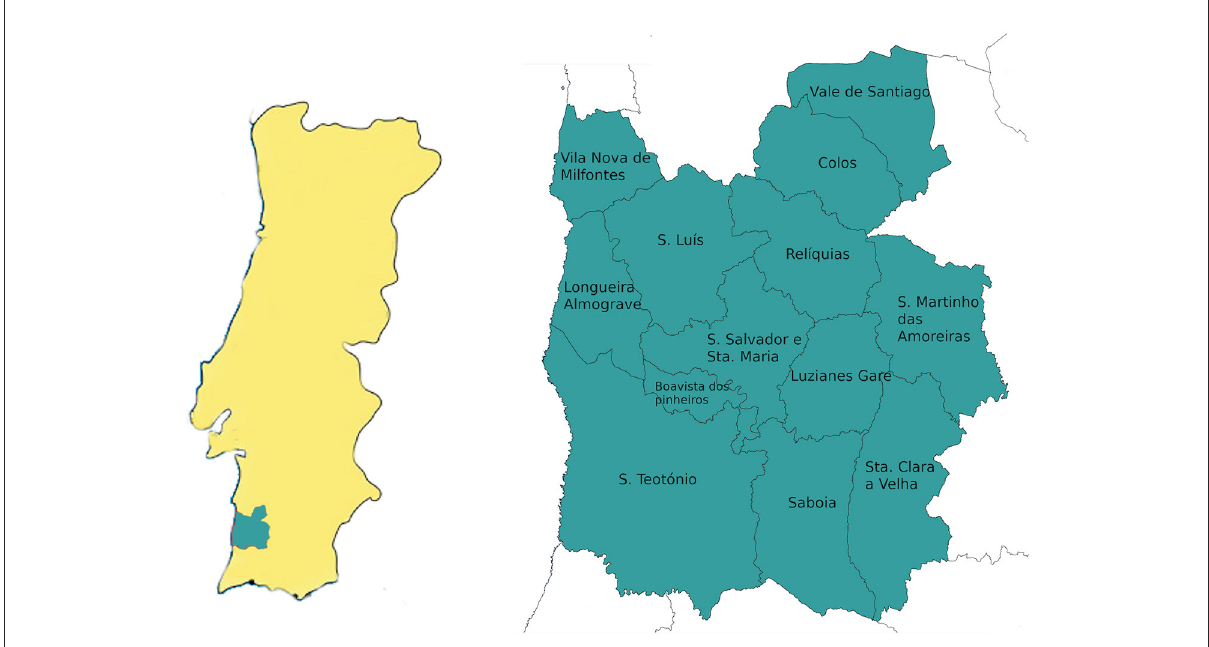
FIGURE1 Map of Odemira. Source: Município de Odemira (2016).